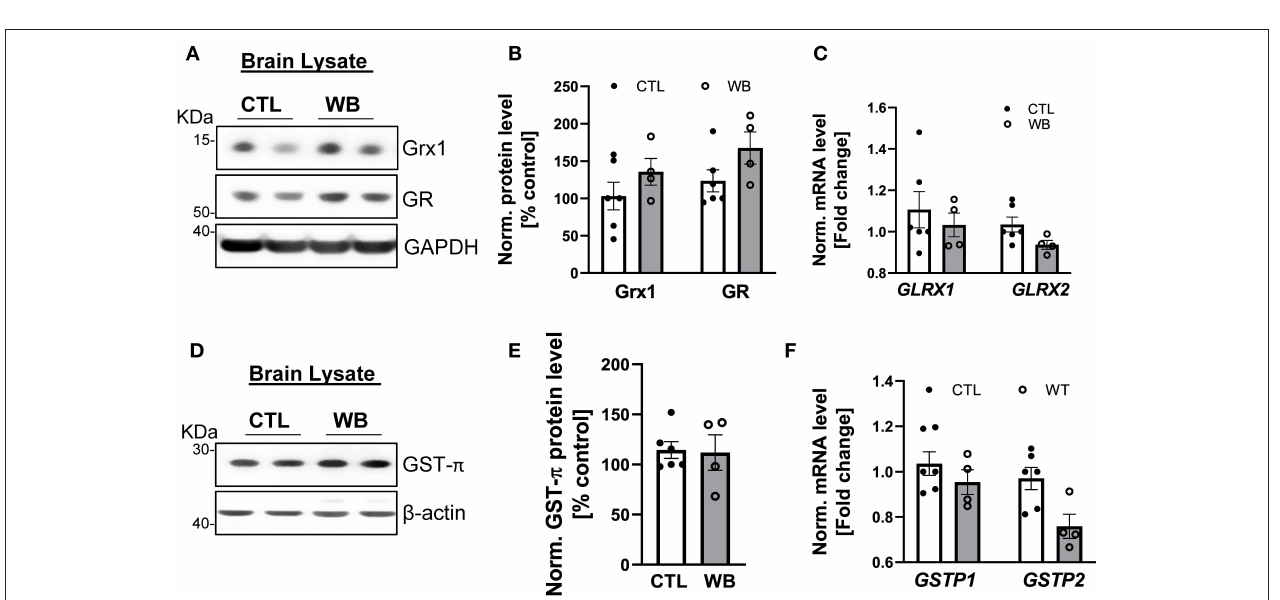
FIGURE 6 | Weekend-binge drinking has no effect on the expression of Grx1, GR and GST- π in brain tissue despite increased protein S-glutathionylation. (A–F) Brain tissue of control (CTL) and Weekend-binge (WB) ethanol-fed mice show no alteration in the expression of Grx1 and GR (A,B) on protein or (C) mRNA expression level. Additionally, no significant changes in the (D,E) protein expression and (F) mRNA expression of GST- π were observed. (A,D) Representative immunoblot results and (B,E) densitometric analysis of Grx1, GR and GST- π in the tissue lysate. (C,F) mRNA results of GLRX1, GLRX2, GSTP1 and GSTP2 in the tissue lysate. Bars represent mean ratio ± error propagated S.E.M. ( n = 4–6, Student t